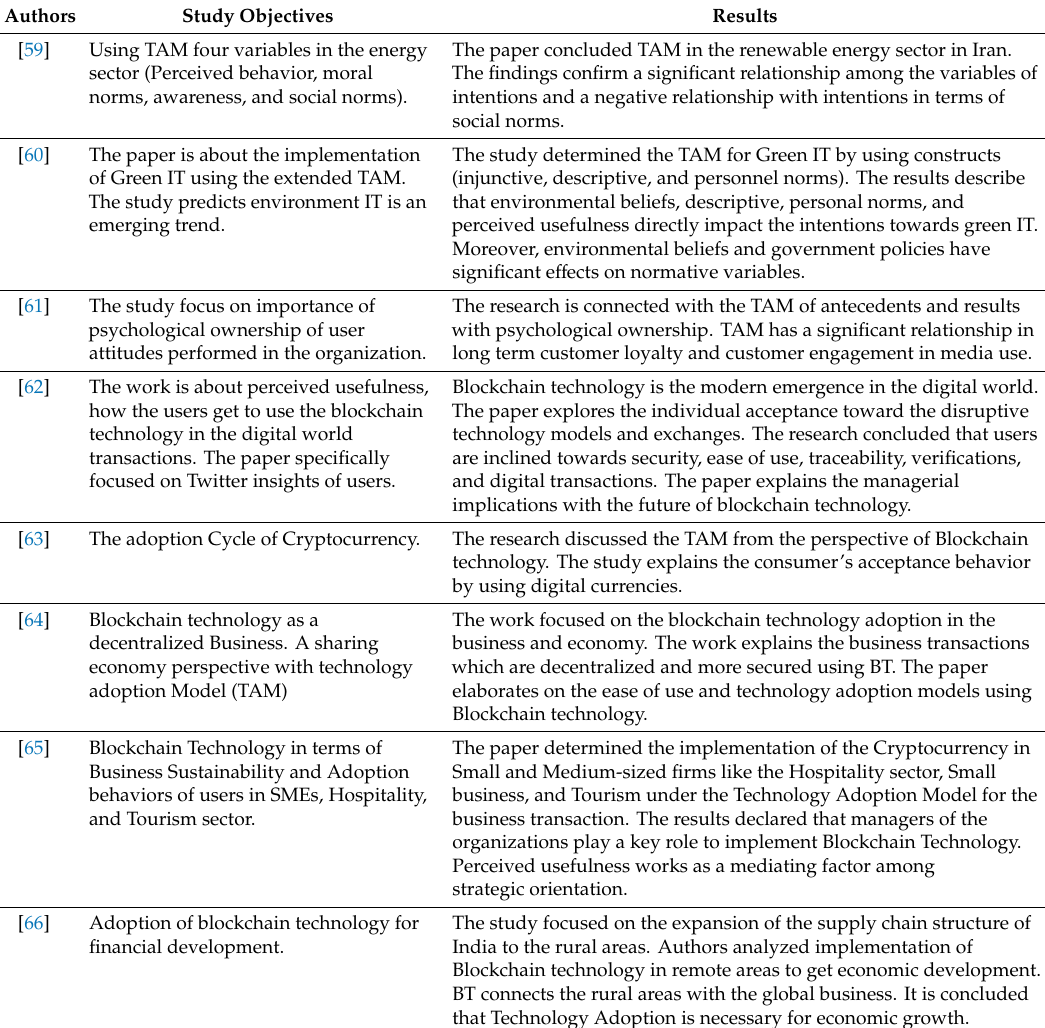
Table 1. Technology Acceptance Model